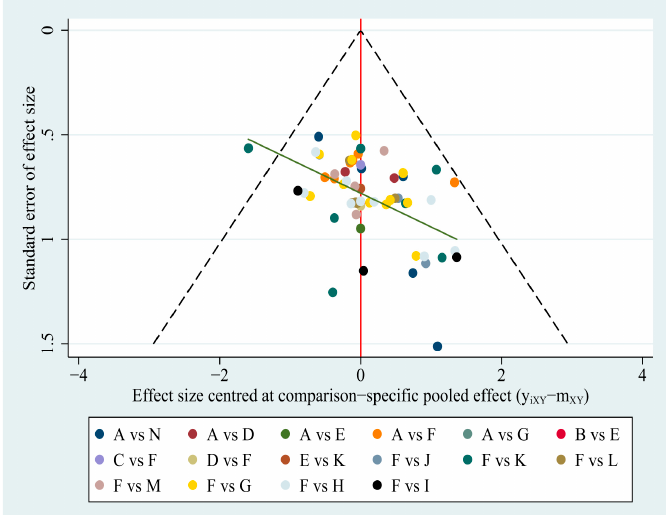
Figure 7. The “comparison-adjusted” funnel plot of total clinical effective rate.